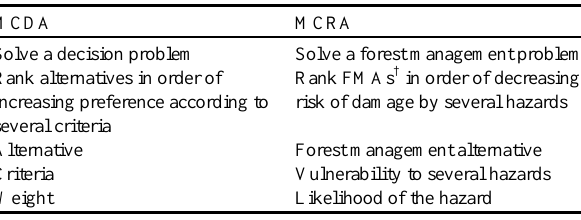
Table 1. Correspondences between objectives and